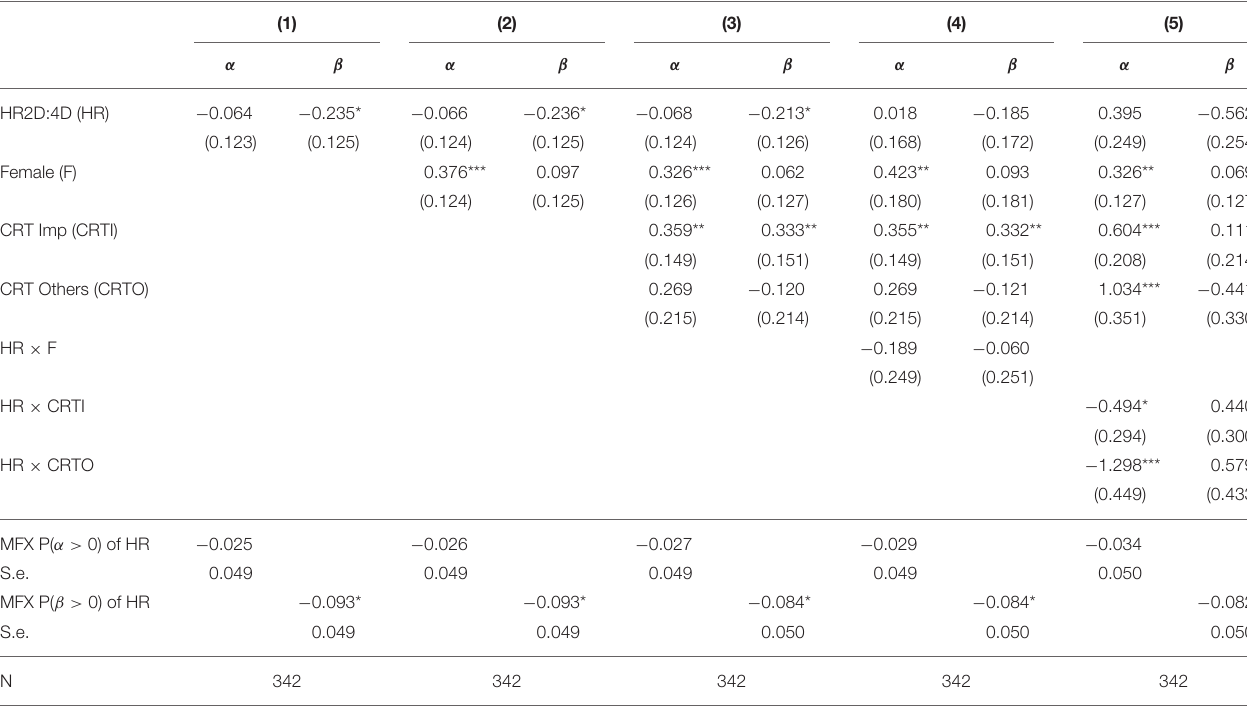
TABLE 3 | Ordered probit regressions of social preferences individual